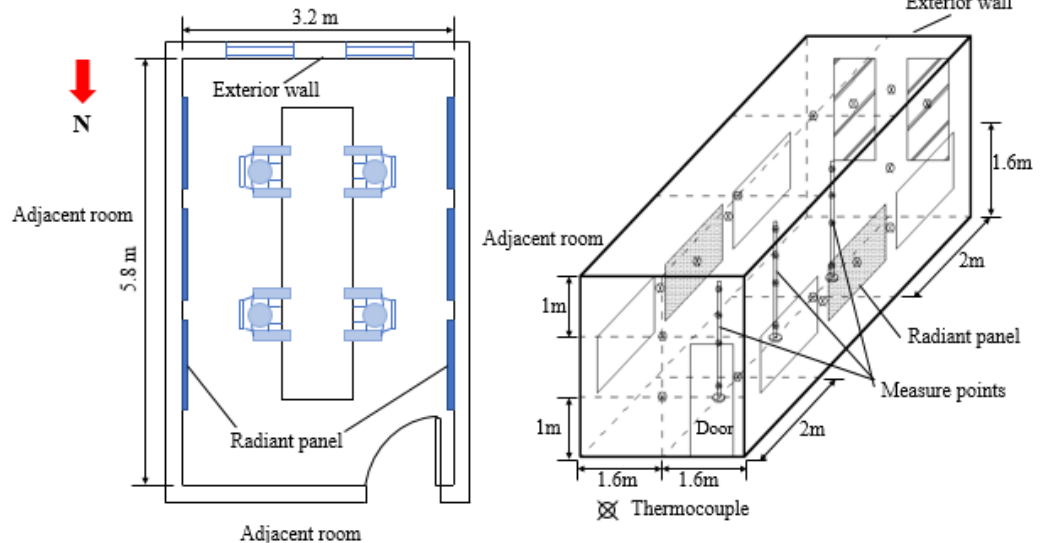
Figure 3. Schematic diagram of the experimental test system.